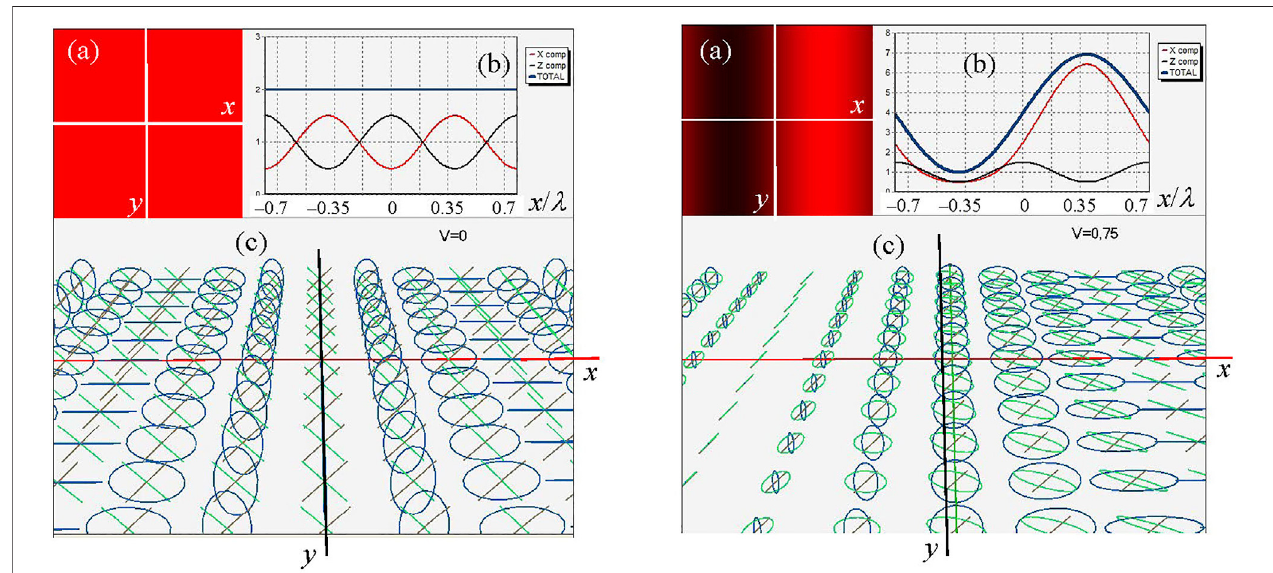
FIGURE 5 | Modulation of the polarization and intensity distribution in case where the superposing waves W1 and W2 of Figure 1A are not completely coherent. (A) 2D intensity distribution (cf. Figure 3B ); (B) Intensities of the partial polarization components and the resulting fi eld; (C) schematic view of the polarization ellipses in